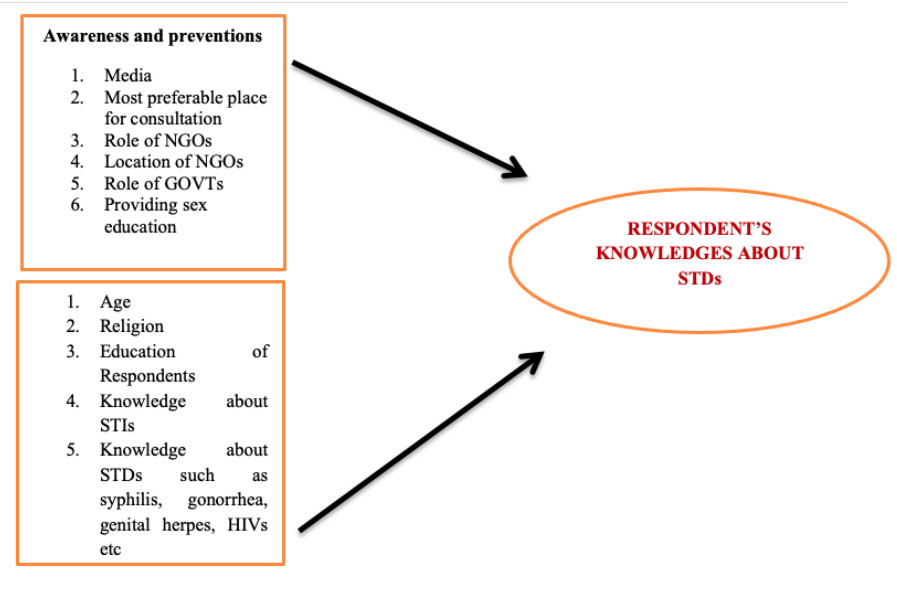
Figure 1: Conceptual